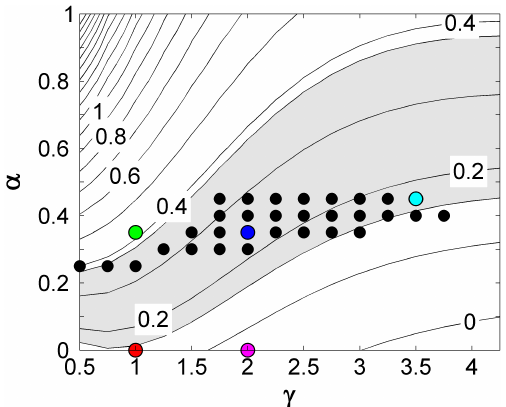
Figure 8. Model hindcasts of the mean rate of sea level rise (mmyr − 1 ) from ice loss from the AIS for the period AD1993– 2010 as functions of model parameters γ and α . The present IPCC best estimate for the range of this mean rate is shaded (Vaughan et al., 2013). The black dots mark hindcasts that meet all three paleo- reconstruction targets (from Fig. 7). The colored dots mark the five hindcasts of Table 2 and Fig. 6 with the Fig. 6 coloring